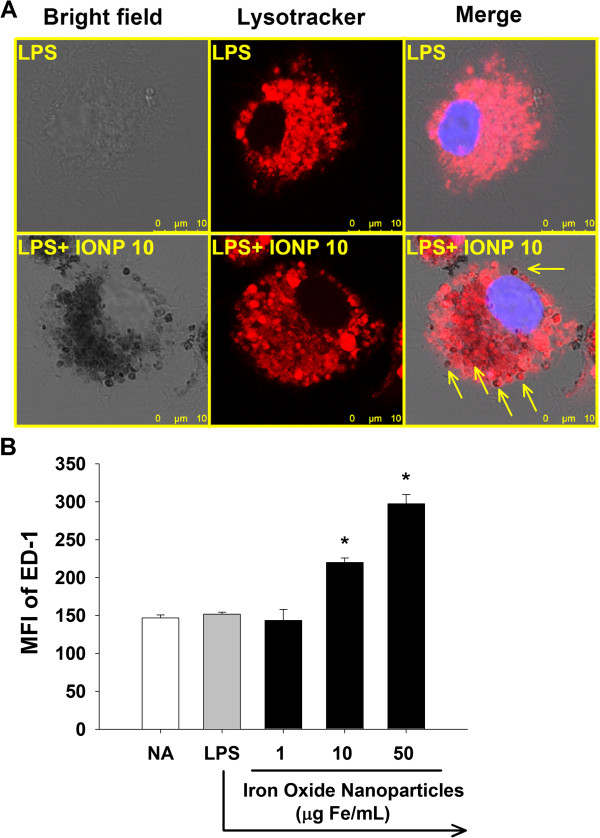
IONPs located in lysosomes and increased the number of lysosomes in LPS-stimulated microglia. Primary microglial cells (4 × 105 cells/mL) were either left untreated (naïve; NA), or pretreated with IONPs (1–50 μg Fe/mL) for 30 min followed by stimulation with LPS (100 ng/mL) for 24 h. (A) The lysosomes of cells were visualized by confocal microscopy with LysoTracker (red) staining. Cells treated with IONPs show an extensive distribution of the internalized dark brown dots of IONPs. Arrows indicate the colocalization of some dark brown spots and lysosomes. (B) The expression of ED-1 was measured by flow cytometry. Data are expressed as the mean ± SE of triplicate cultures. Results are a representative of three independent experiments. *p < 0.05 compared to the LPS group. MFI, mean fluorescence intensity.